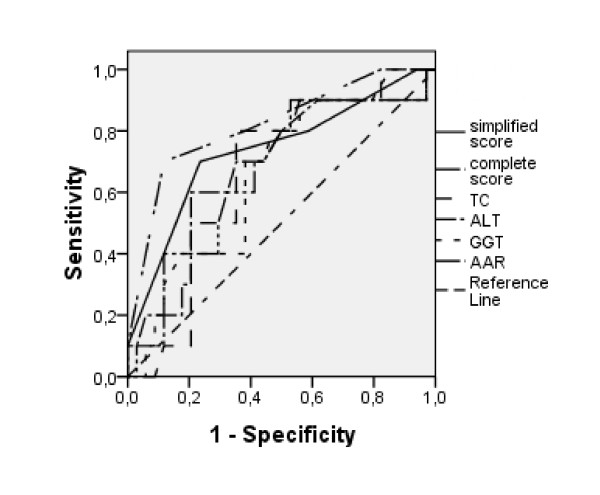
ROC curves showing the sensitivity and specify to identify severe steatosis.